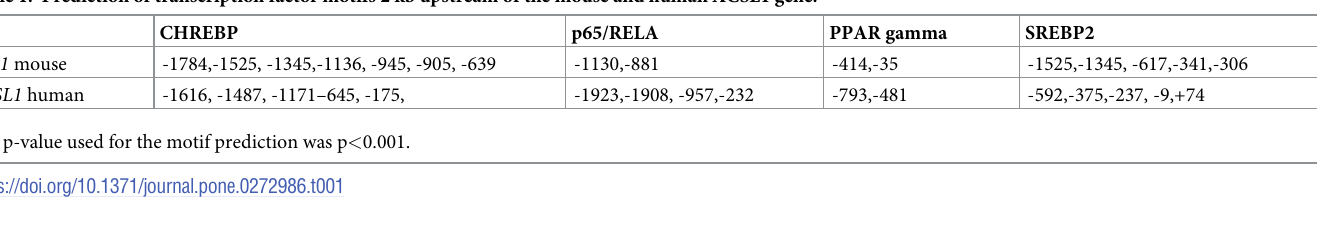
Table 1. Prediction of transcription factor motifs 2 kb upstream of the mouse and human ACSL1 gene.